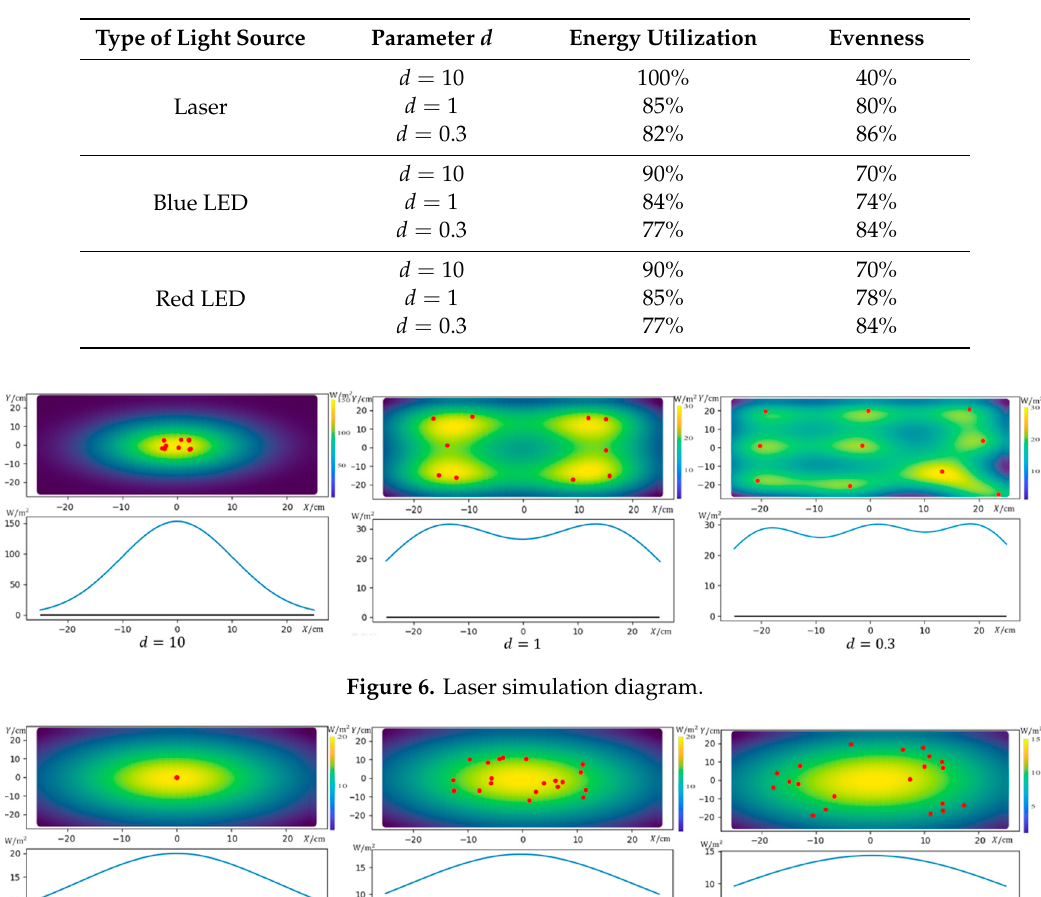
Table 2. Simulation results.